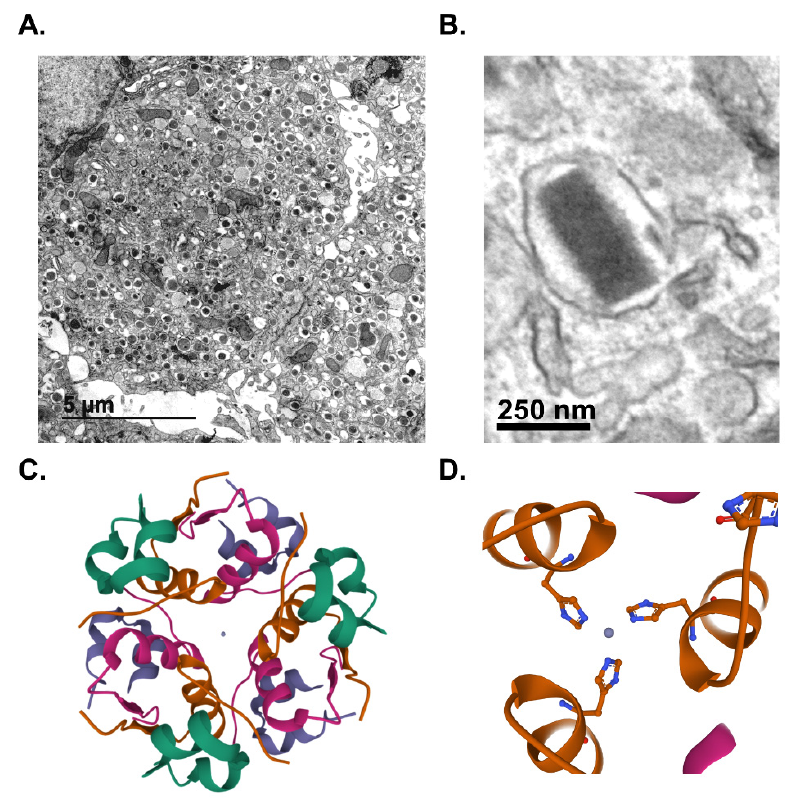
Figure 1. Insulin is stored in dense-core secretory granules. Transmission electron micrographs of mouse β -cells depicting dense-core secretory granules ( A ) or a single insulin secretory granule from a human β -cell ( B ). Crystal structure of hexameric insulin with central Zn 2+ ions in gray ( C ) coordinated by histidine (A10) side chains ( D ). ( C , D ) Paired insulin dimers within the hexamer are colored separately for visual clarity. Lavender or green denote the A chains; purple or green denote the B chains. Images were created using Mol* of 2INS from the Research Collaboratory for Structural Bioinformatics Protein Data Bank (RCSB PDB) [14,15].